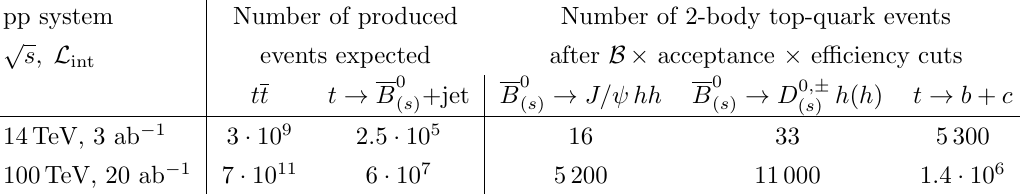
Table 12 . Summary of the total number of top-quark events expected in the various (cid:12)nal states p considered in this work for pp collisions at s = 14 TeV (3 ab (cid:0) 1 ) and 100 TeV (20 ab (cid:0) 1 ). The (cid:12)rst two columns list the number of produced pair tt and two-body t -quark decay events expected. The last three columns list the number of 2-body tt ! ( B 0 + c; u )+ X top-quarks events expected in mea- s surements using B 0 ! J= hh and B 0 ! D 0 ; (cid:6) h ( h ) with h = (cid:25); K , and t ! j b + j c (cid:12)nal ( s ) ( s )